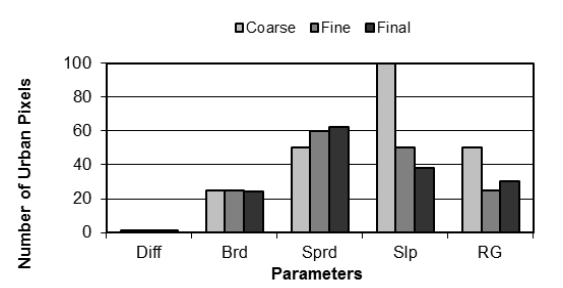
Figure 4. Urban growth response of different coefficiencies.